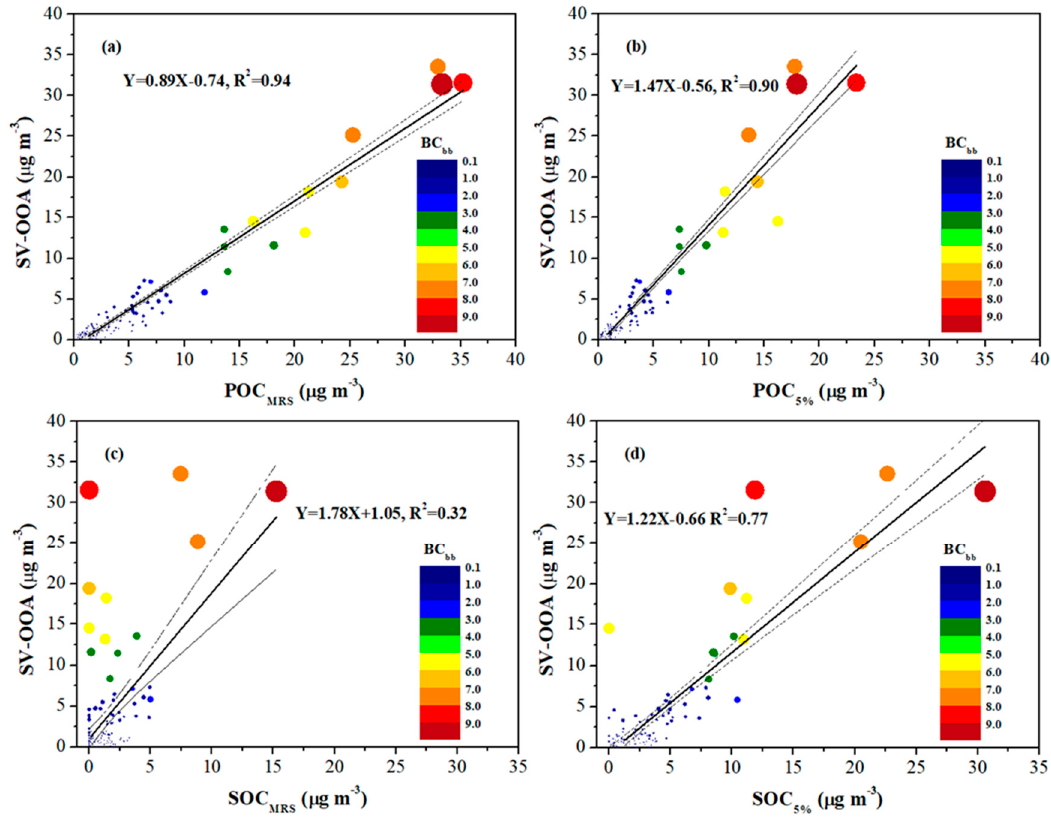
Figure 7. Correlation between POC ( a , b ) and SOC ( c , d ) estimates from the MRS ( a , c ) and 5% ( b , d ) percentile methods against the semi-volatile oxygenated organic aerosol (SV-OOA) component in Athens during December 2016 to January 2017. The colored scale corresponds to BC bb deriving from aethalometer (AE-33) measurements at the same site.